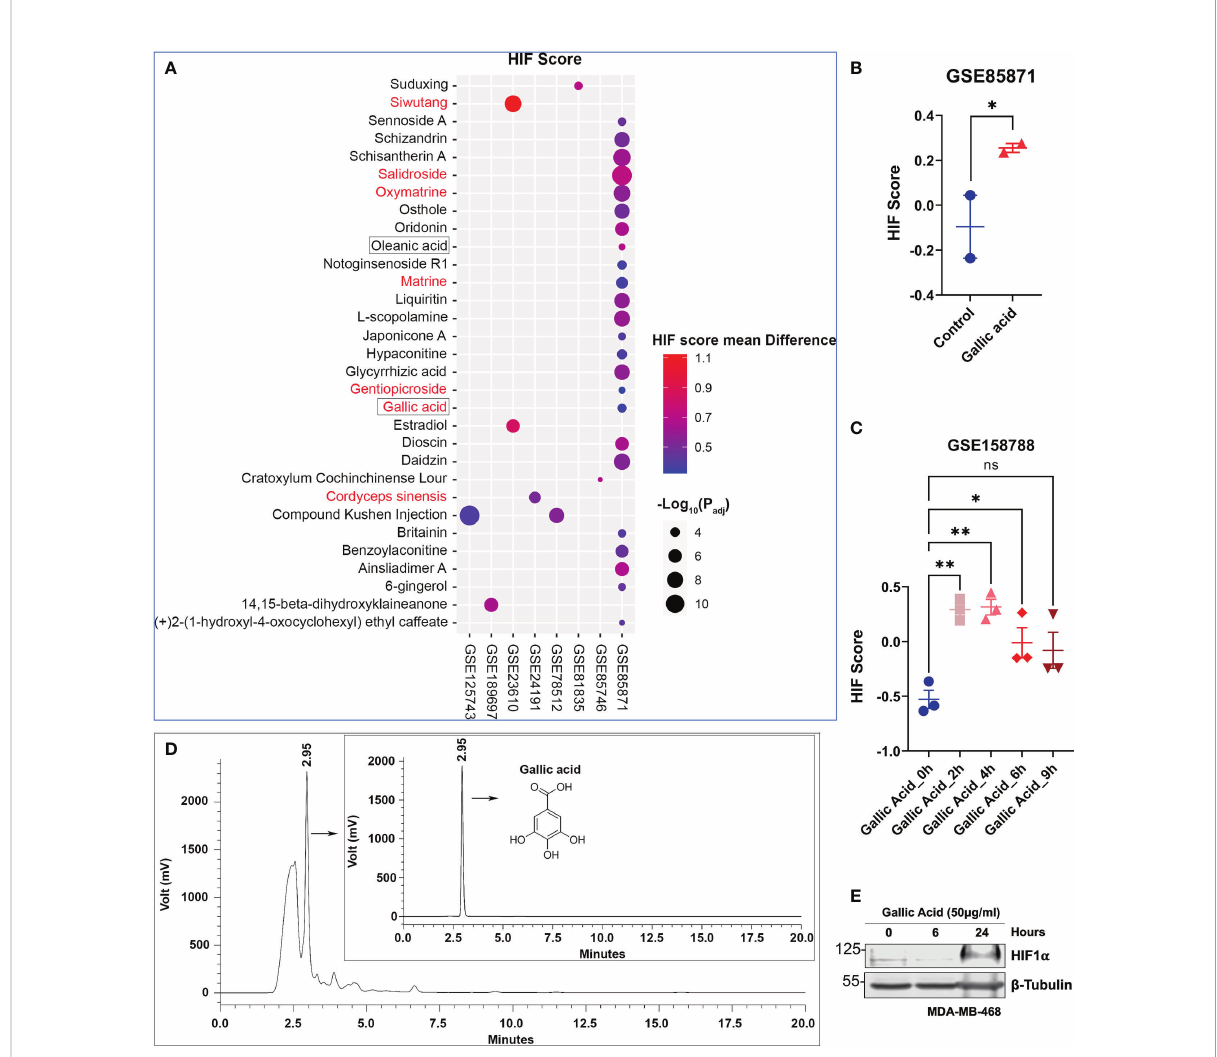
FIGURE 6 Integrated analysis suggests a role for gallic acid within Limonium Sinense in mediating hypoxia-inducible factor (HIF) activation. (A) Scatter plot showing natural compounds or herbal extracts that can up-regulate the HIF score. Compounds with red colour are water soluble, and those framed are reported to be present in Limonium Sinense . The sizes of circles represent the -Log10 of the P adj values, and the colours of circles represent the HIF score mean difference of each compound compared with control samples. (B, C) Graphs showing the effect of gallic acid on the HIF score from Gene Expression Omnibus (GEO) dataset GSE85871 (B) and GSE158788 (C) . Data are mean ± SEM. ns, not signi fi cant; * P < 0.05; ** P < 0.01 by the Student ’ s t -test (B) and one-way ANOVA (C) , respectively. (D) Chromatograms (HPLC/UV) of Limonium Sinense water extracts and gallic acid (insert) in 271 nm. The retention time (2.95 min) and structure for gallica acid are indicated. (E) Protein expressions of HIF-1 a in MDA-MB-468 cells treated with or without gallic acid (50 m g/ml) for the indicated time. b -Tubulin was used as a loading